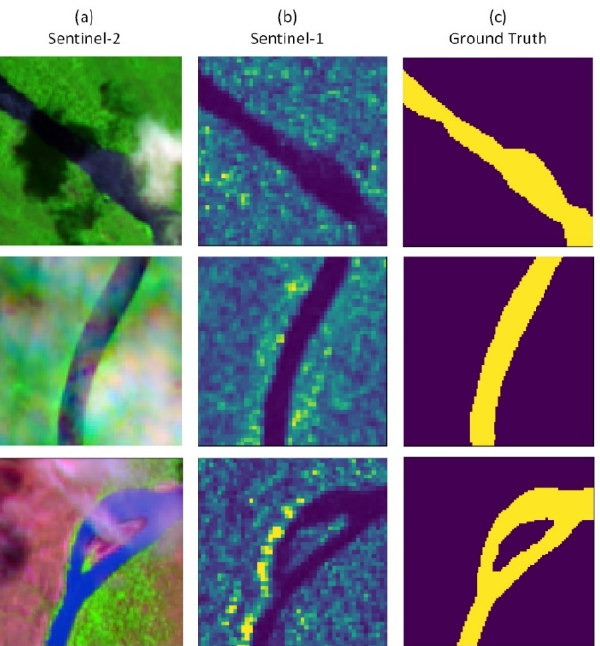
Figure 2. Example of sample visualization and manual ground truth in the large-scale multi-source river imagery dataset: ( a ) false color composite image of Sentinel-2 satellite data; ( b ) false color composite image of Sentinel-1 satellite data; ( c ) manually-created ground truth (yellow color indicates water extent).